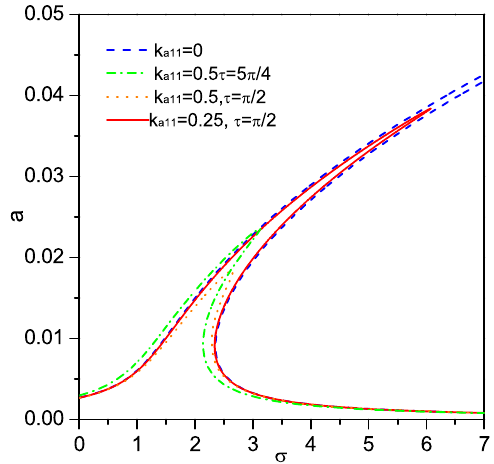
Figure 5. The amplitude-frequency curve of the superharmonic resonance.